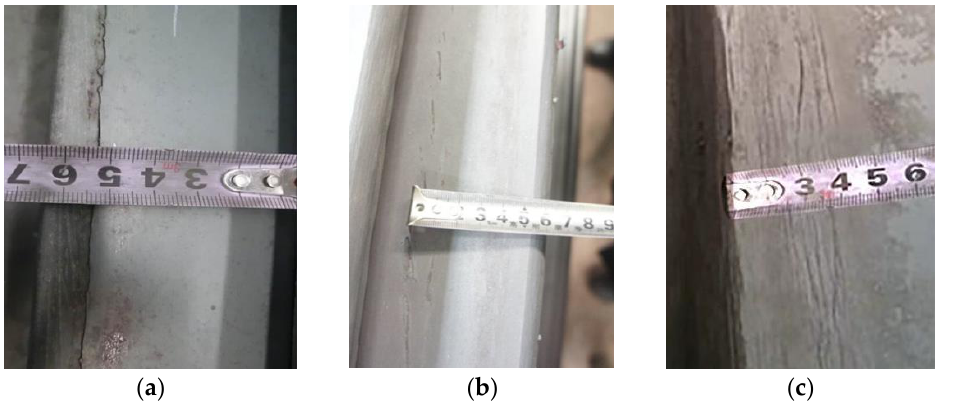
Figure 1. Morphology of edge seam defects on heavy plates. ( a ) Long edge seam crack; ( b ) intermit- tent edge seam crack; ( c ) reticulated edge seam crack.